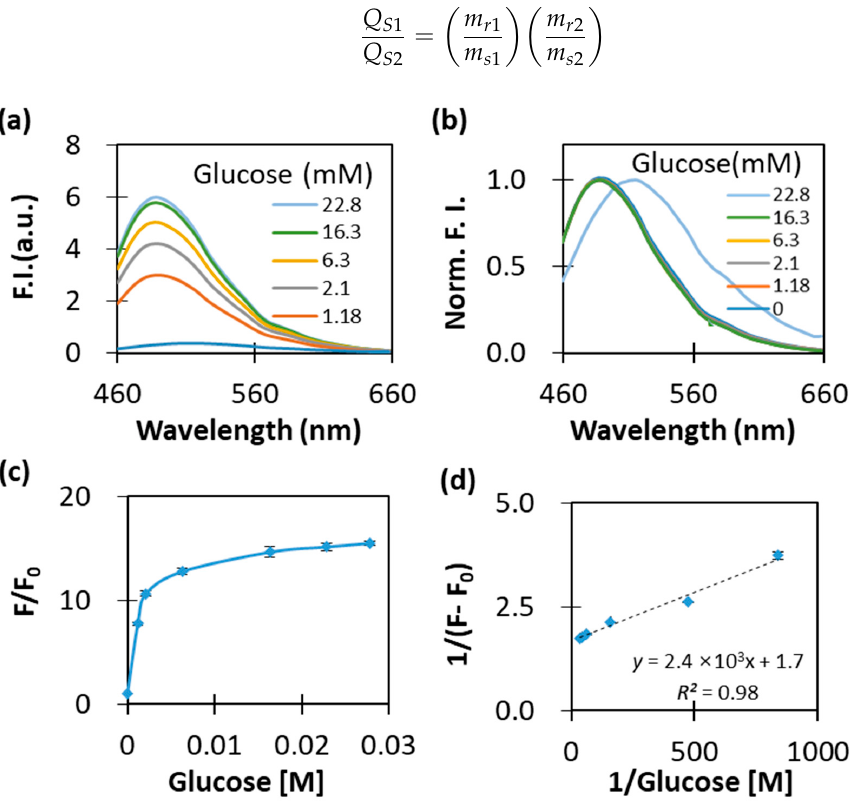
Figure 3. Glucose binding properties of AcTDA . ( a ) Emission spectra and ( b ) normalized emission spectra for glucose at concentrations of 0–500 mg/dL. Fluorescence intensity at the maximum wavelength was used for the normalization. ( c ) Relative fluorescence intensity. ( d ) Benesi–Hildebrand plot.